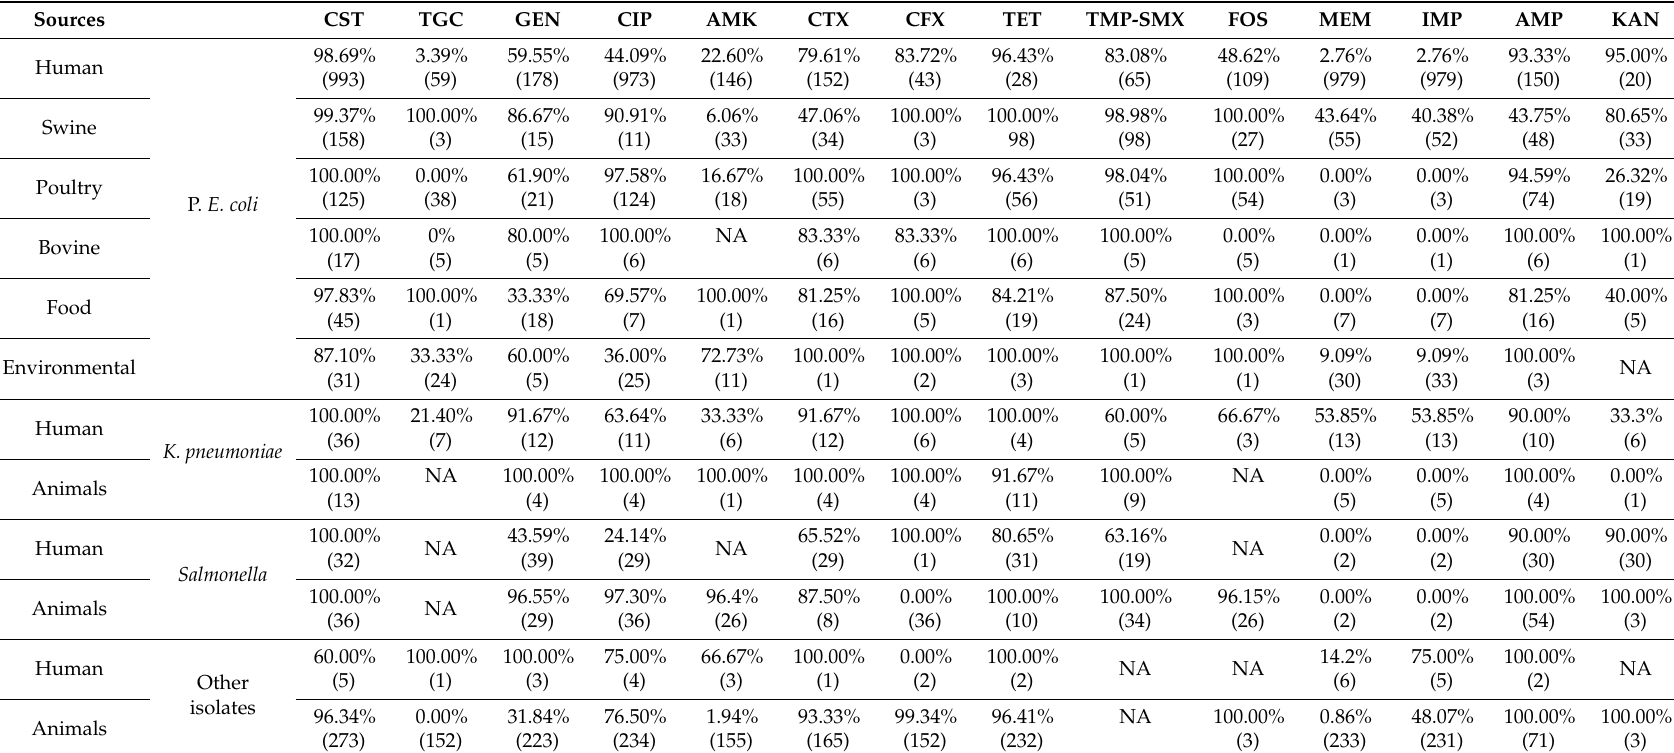
Table 2. Antibiotic resistance of isolates that harbor mcr